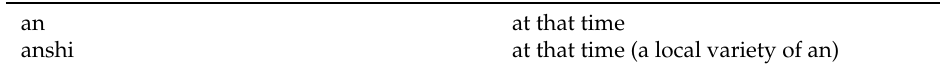
Table 10. Discourse